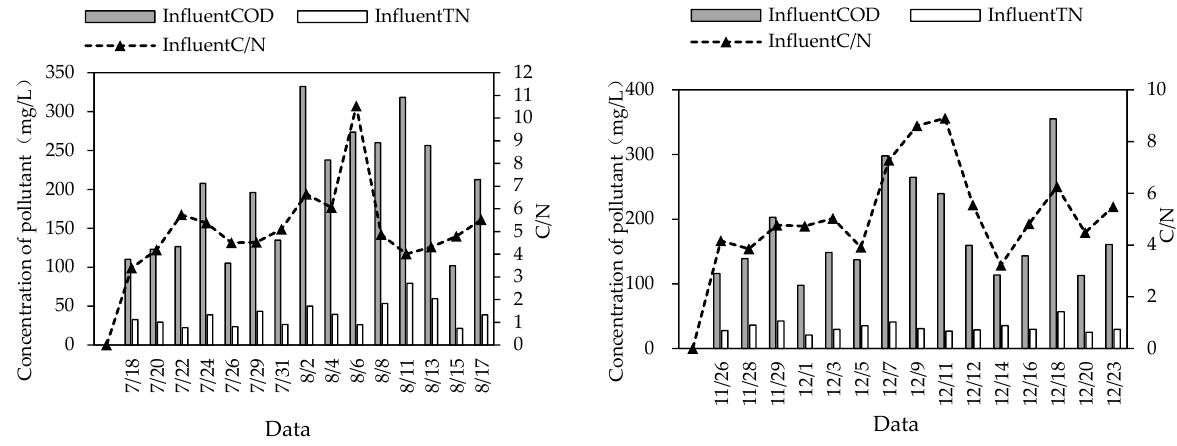
Figure 6. C/N of influent water in combined system in summer and winter.